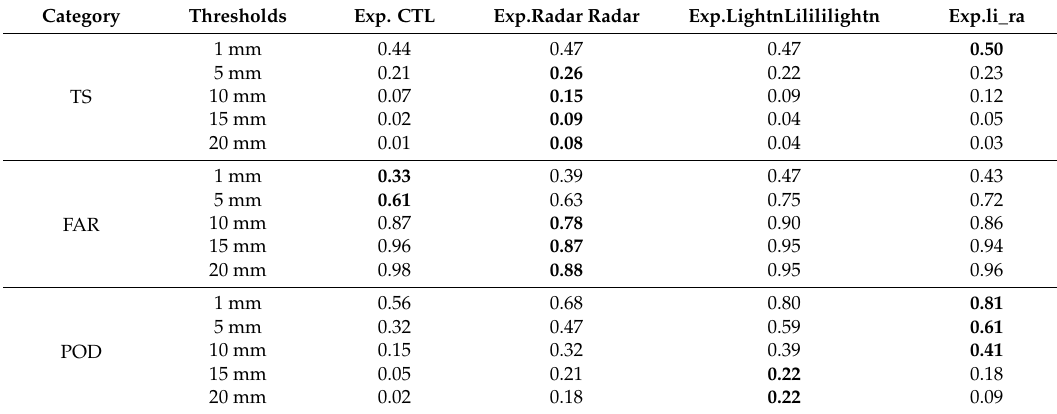
Table 1. Threat scores (TS), false alarm ratio (FAR) and probability of detection (POD) for the 6 h accumulated precipitation in Exp. CTL, Exp. radar, Exp. lightn and Exp. li_ra at thresholds of 1 mm, 5 mm, 10 mm, 15 mm and 20 mm. Gray shaded areas denote the best results for each threshold level. The perfect score for TS and POD is 1.00 and the no skill score is 0.00. The perfect score for FAR is 0.00 and the no skill score is